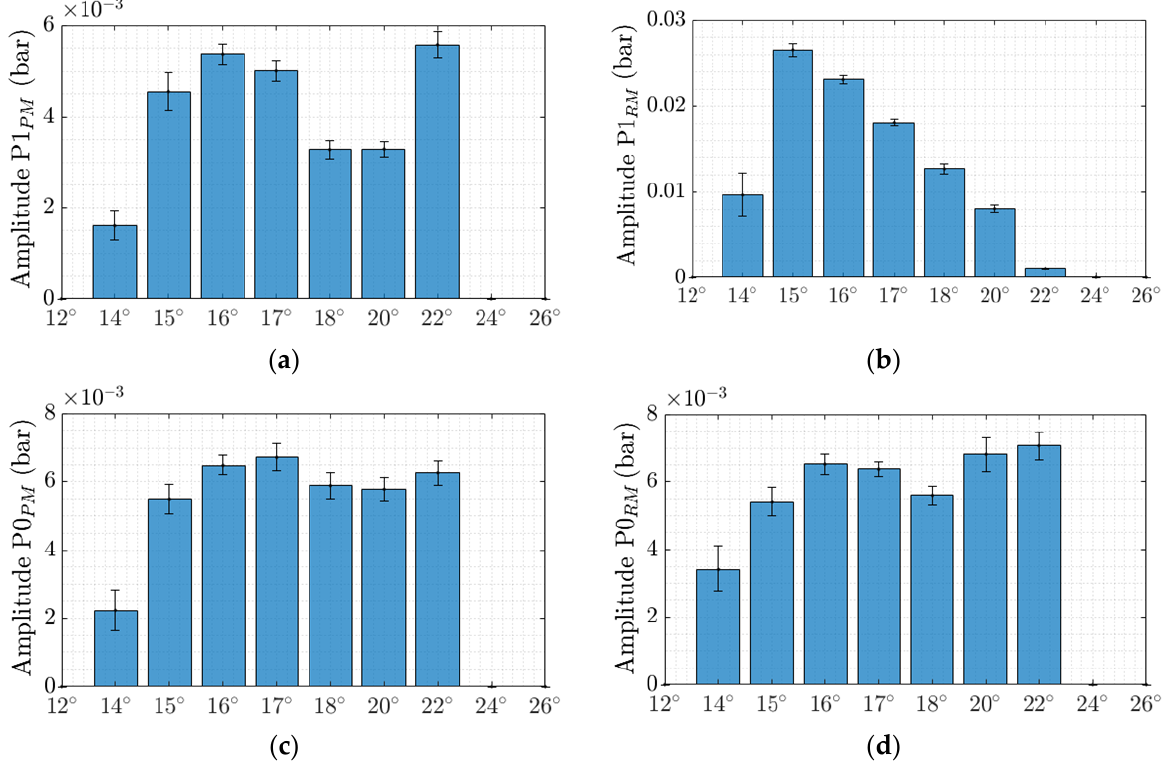
Figure 9. Pressure levels measured at f rvr on the draft tube cone below the runner for the PM ( a ) and the RM ( b ), and further downstream before the elbow for the PM ( c ) and the RM ( d ) at α from 12° to 26°.